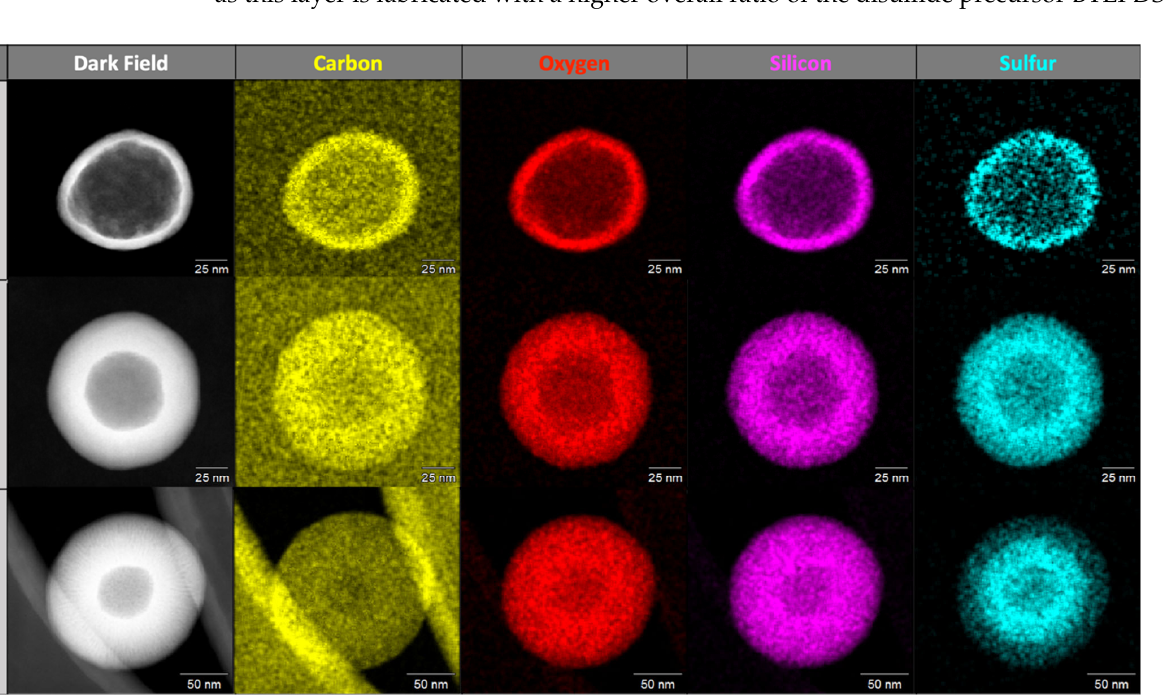
Table 1. Particle diameter and shell thickness measured by TEM, hydrodynamic diameter, polydis ‐ persity index (PdI), and zeta potential measured by DLS, of all fabricated silica nanoparticles.